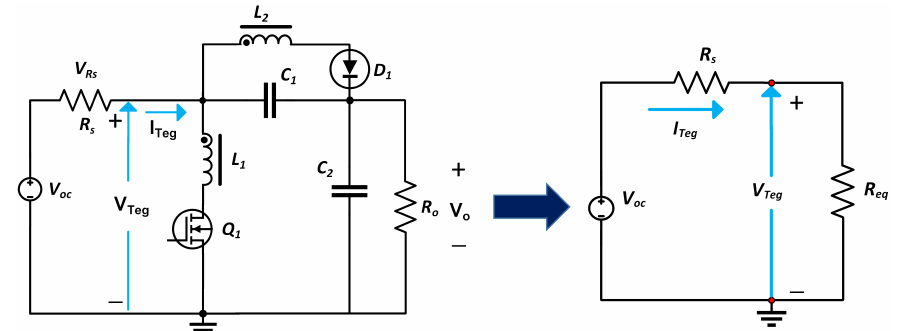
Figure 3. Equivalent resistance seen by the